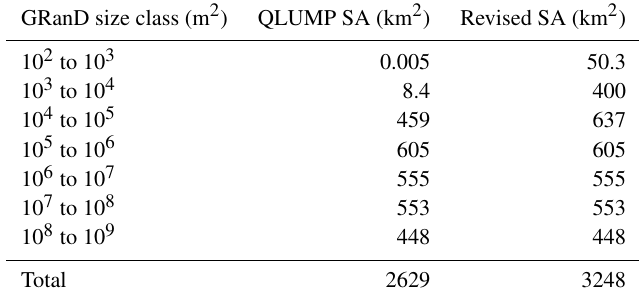
Table A2. Surface area (SA) of Queensland artificial water bodies within each GRanD database size class showing the official land use assessment estimates (QLUMP, 2018) and the revised estimates for the smallest three size classes found in this